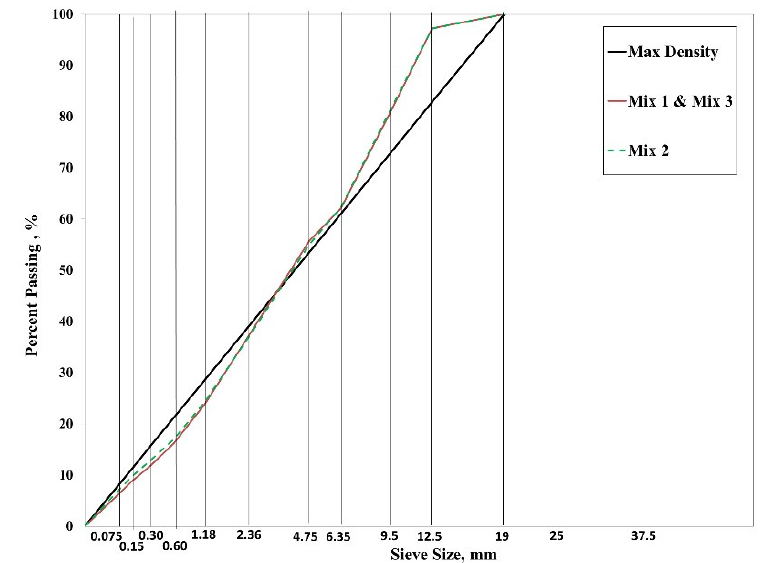
Figure 1. Gradation curves for all three mixes on a 0.45 power chart. The binder content corresponding to the target design air void was selected as the optimum binder content (OBC) for each mix. The volumetrics and the other mix